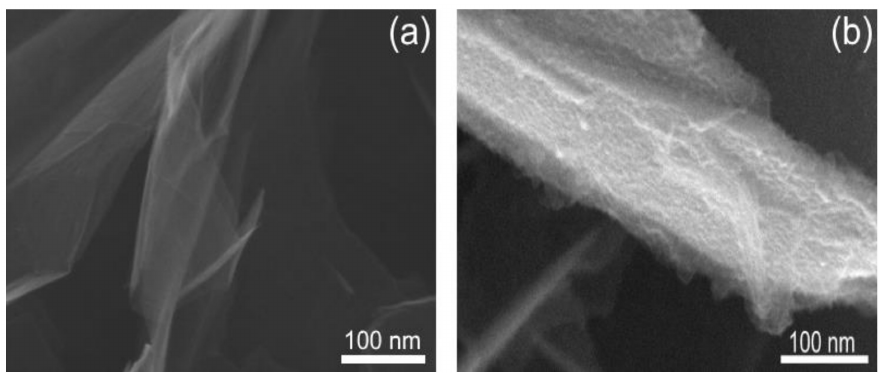
Figure 3. SEM micrograph of the ( a ) unmodified GNP and ( b ) modified GNP by